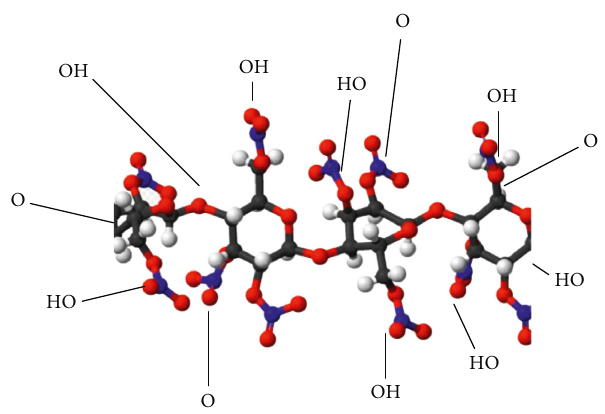
Figure 1: Molecular structure of